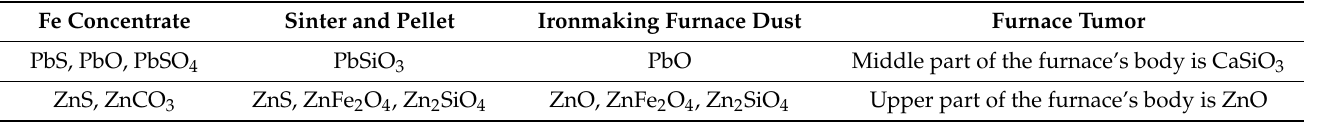
Table 1. Characteristics of Pb and Zn minerals in BF